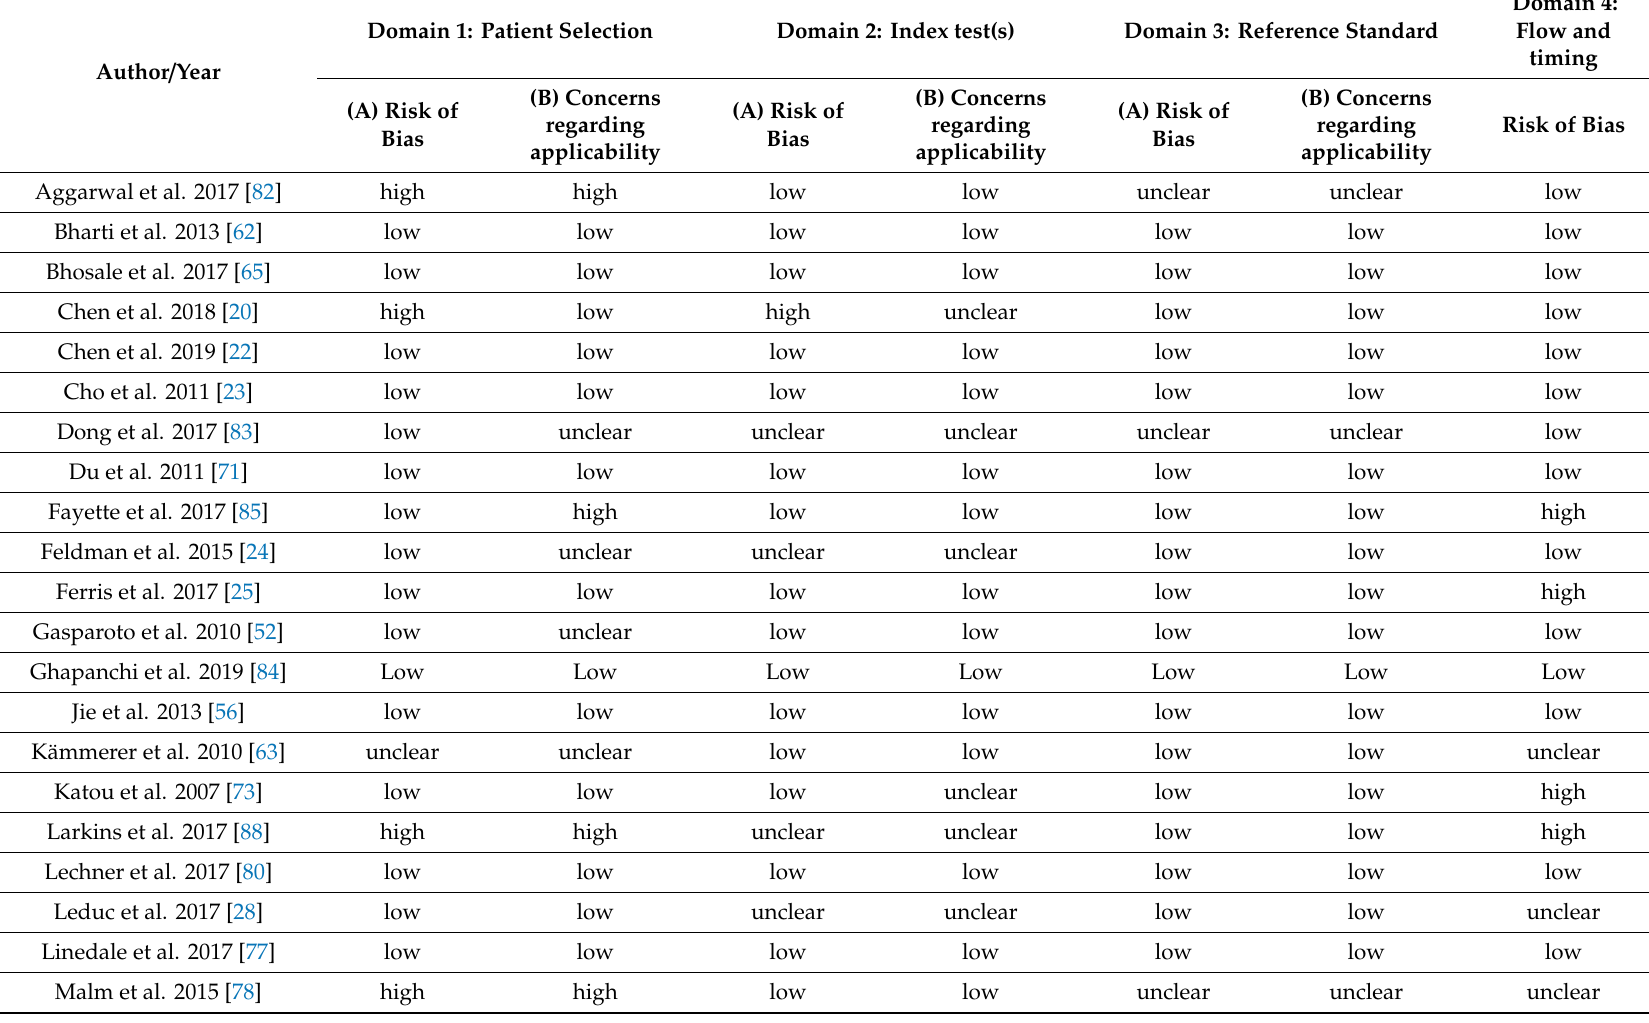
Table 2. Quality Assessment of Diagnostic Accuracy Studies Using the Diagnostic Accuracy Studies 2 QUADAS-2 Revised